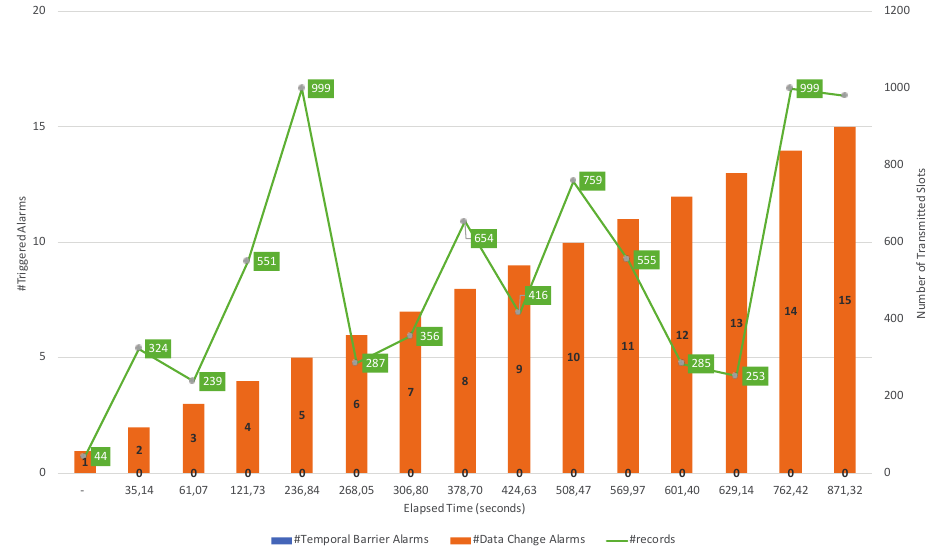
Figure 8. Evolution of the triggered alarms and data transmissions throughout 15 minutes with load- shedding technique enabled (simulation 4).